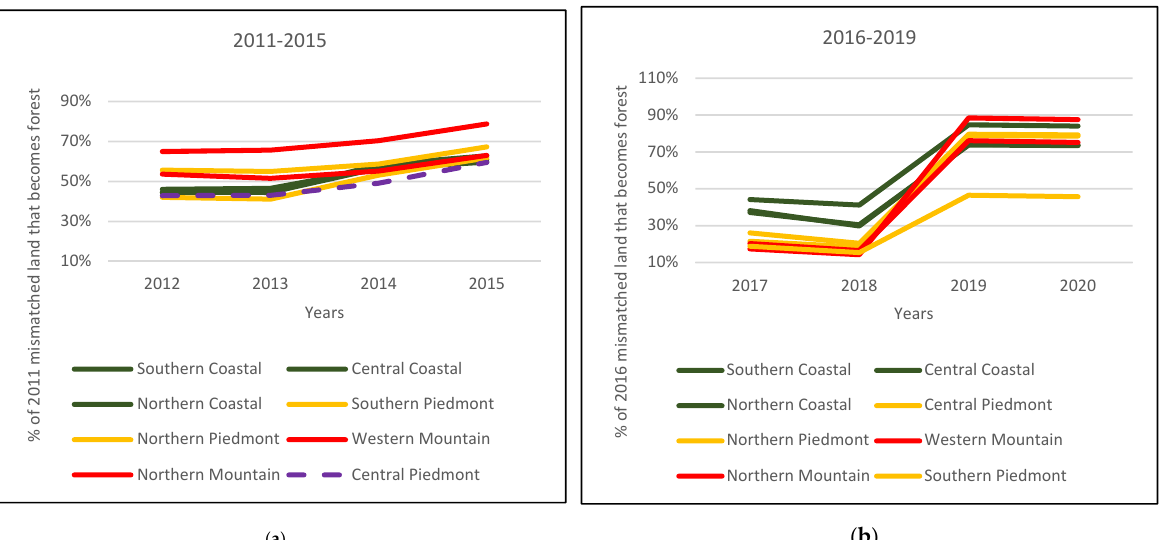
Figure 5. Land identified as forest in the NLCD, but identified as non-forest in in CDL that becomes forest in CDL in subsequent years of data availability; ( a ) percent of mismatched land in 2011 that becomes forest; ( b ) percent of mismatched land in 2016 that becomes forest.